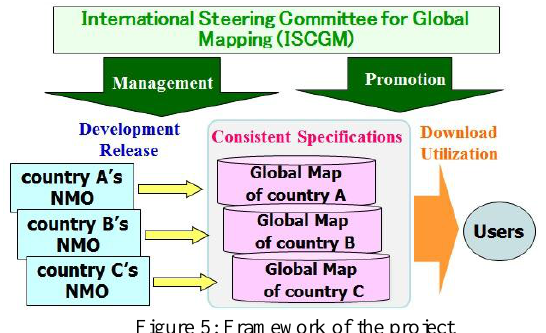
Figure 5: Framework of the project